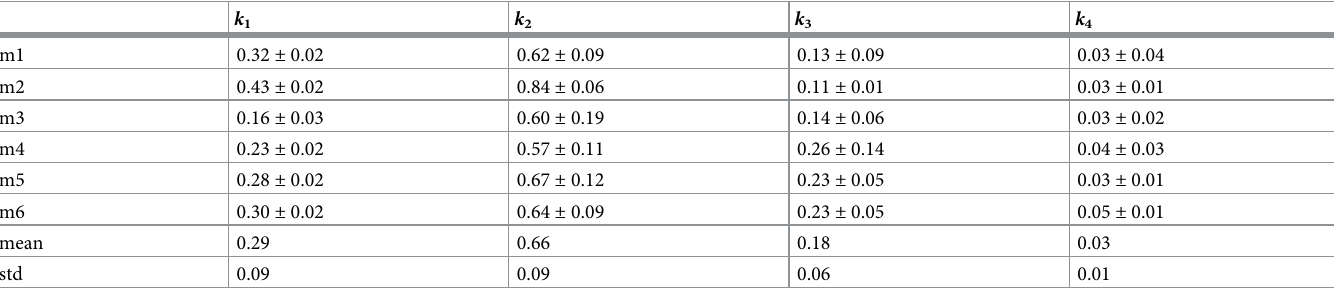
Table 3. Reconstructed kinetic parameters (1/min) of SCM.